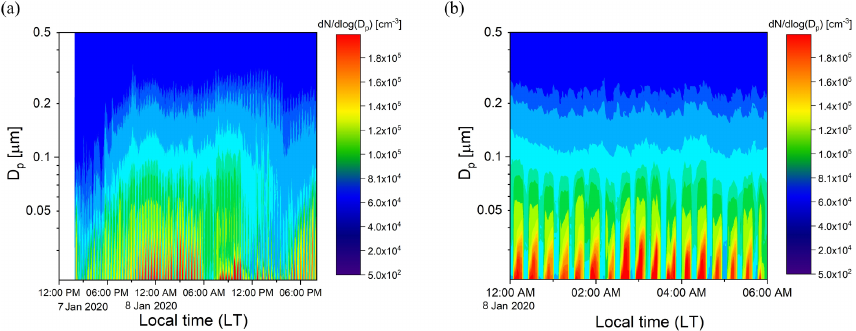
Figure 11. Example time series of size distributions of the aerosol processed by the PFA OFR and that which bypassed it over (a) 30h on 7–8 January 2020 and (b) 6h on 8 January 2020. The bands of high concentration were measured when the aerosol and ambient air were processed through the